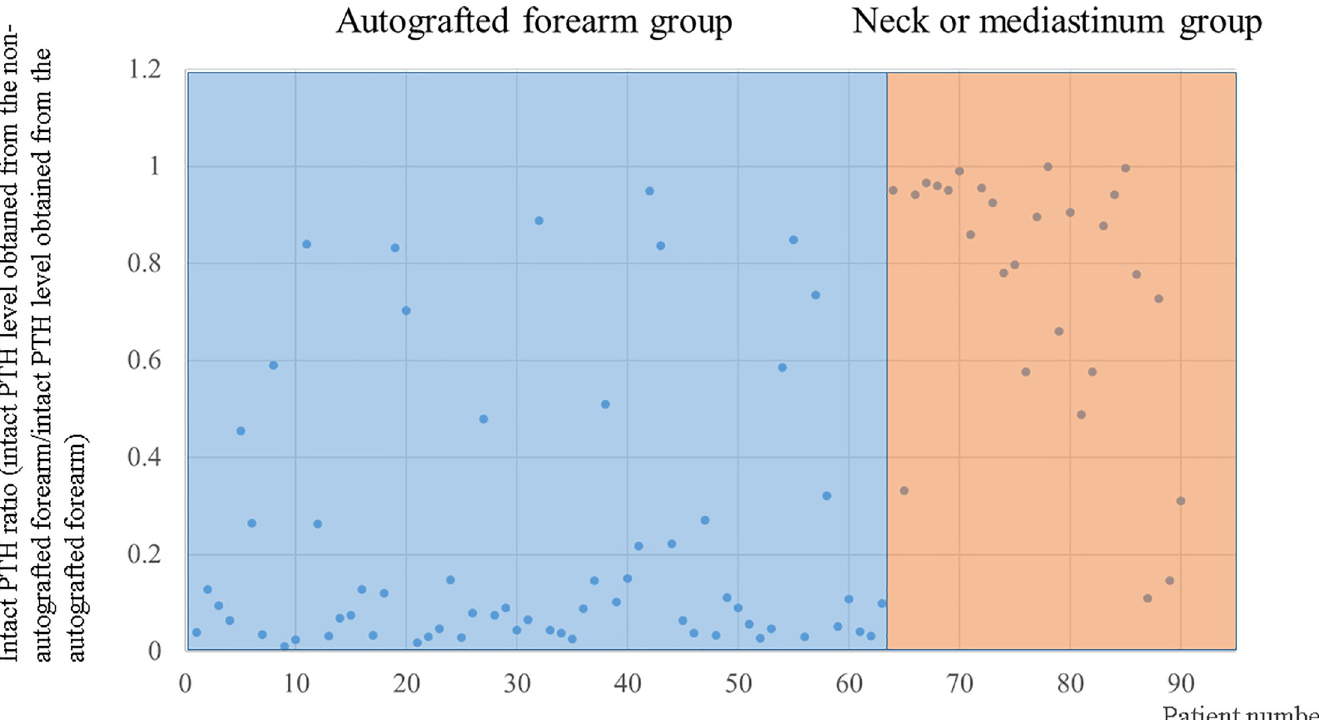
Fig 3. Intact PTH ratios in the autografted forearm group and the neck or mediastinum group. PTH, parathyroid hormone.